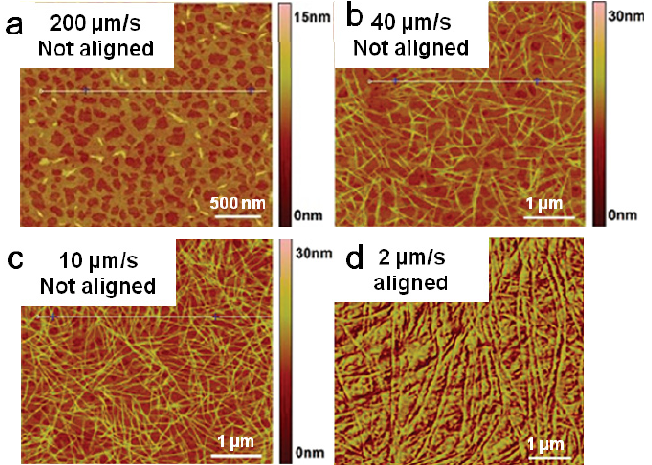
Figure 4. The pBTTT films with ( a – c ) random orientations and ( d ) a good alignment prepared via controlling dip-coating rates (Adapted with permission from [66]. Copyright 2012 American Chemical